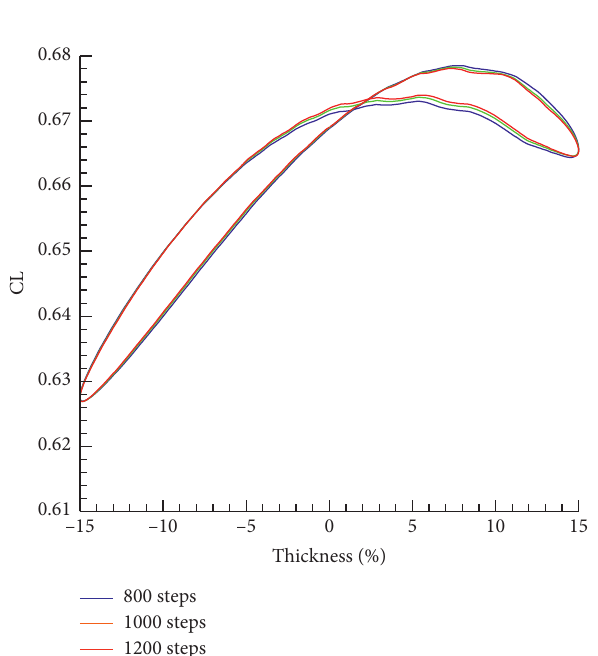
Figure 3: Numerical method and result compared with CT1 case.